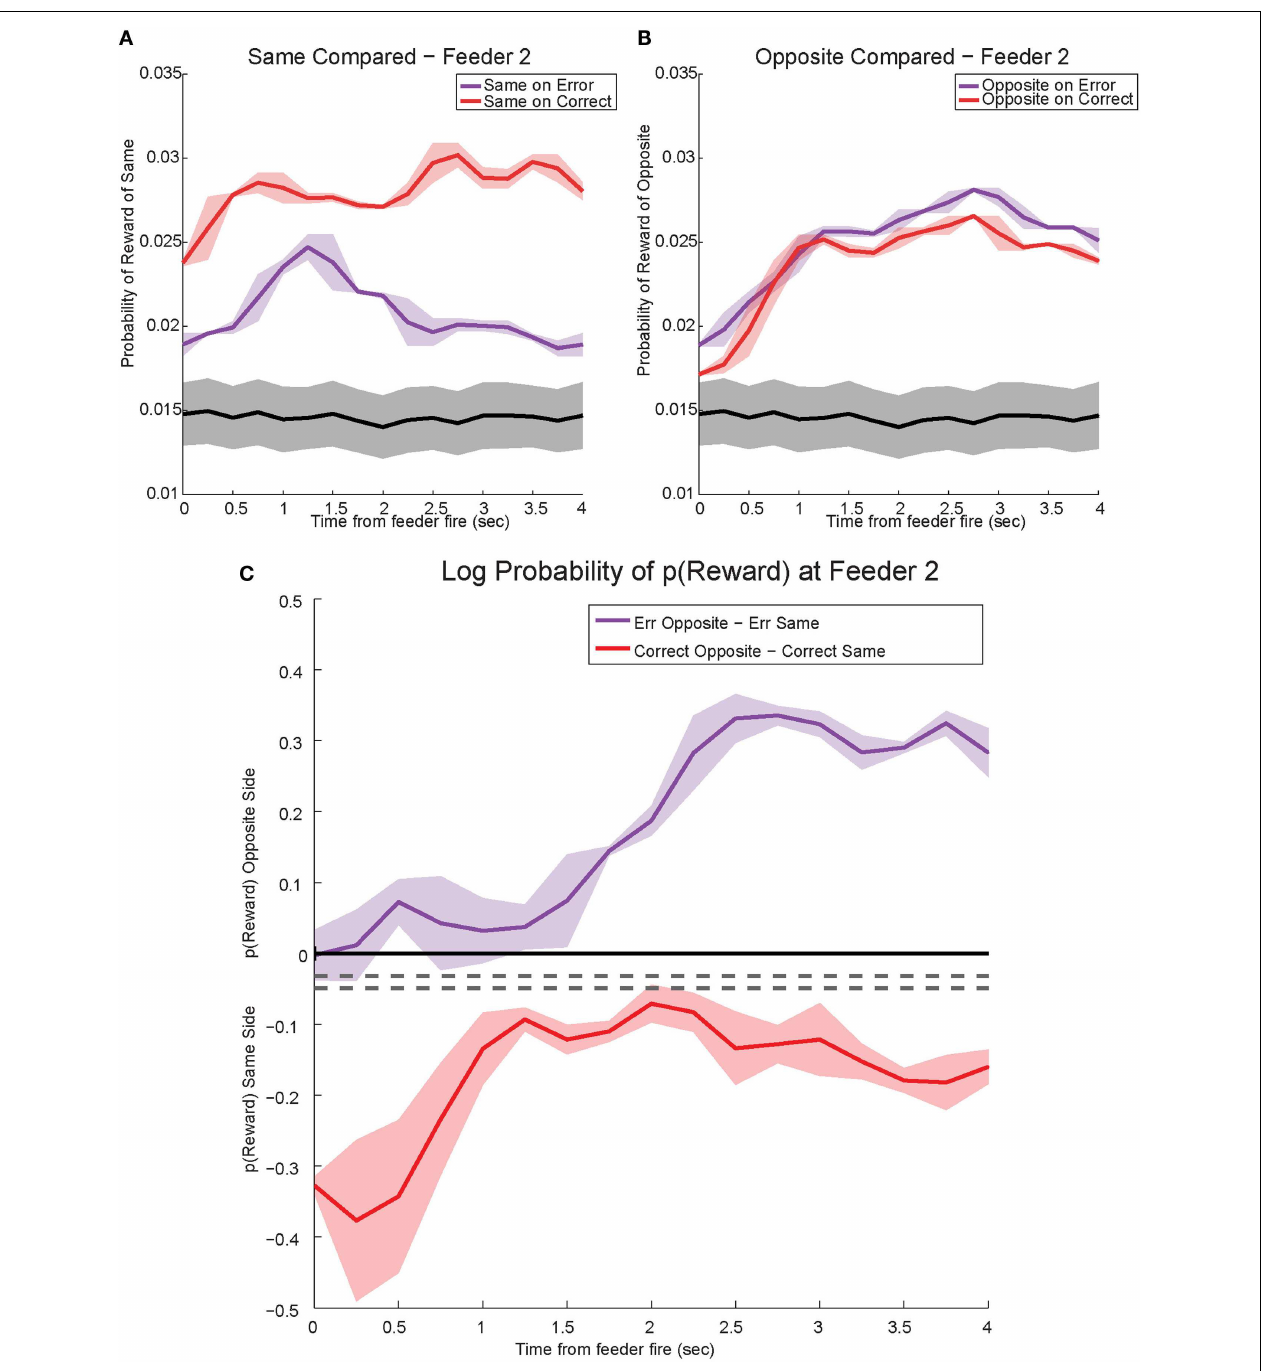
passes. Data was smoothed using a 500-ms moving average. Gray lines represent the upper and lower quartiles for shuffled control, based on shuffling interspike intervals and re-calculating the decoding using unshuffled tuning curves. On errors, the log ratio of p (Reward) at feeder 2 demonstrated a sustained non-local response, [ p (Reward same ) < p (Reward opposite )].This sustained response to the opposite, non-local side during errors may reflect a planning signal. On correct laps, as seen in Figure 13C , the log ratio of p (Reward) at feeder 2 remained local for the duration of the animal’s pause at the reward